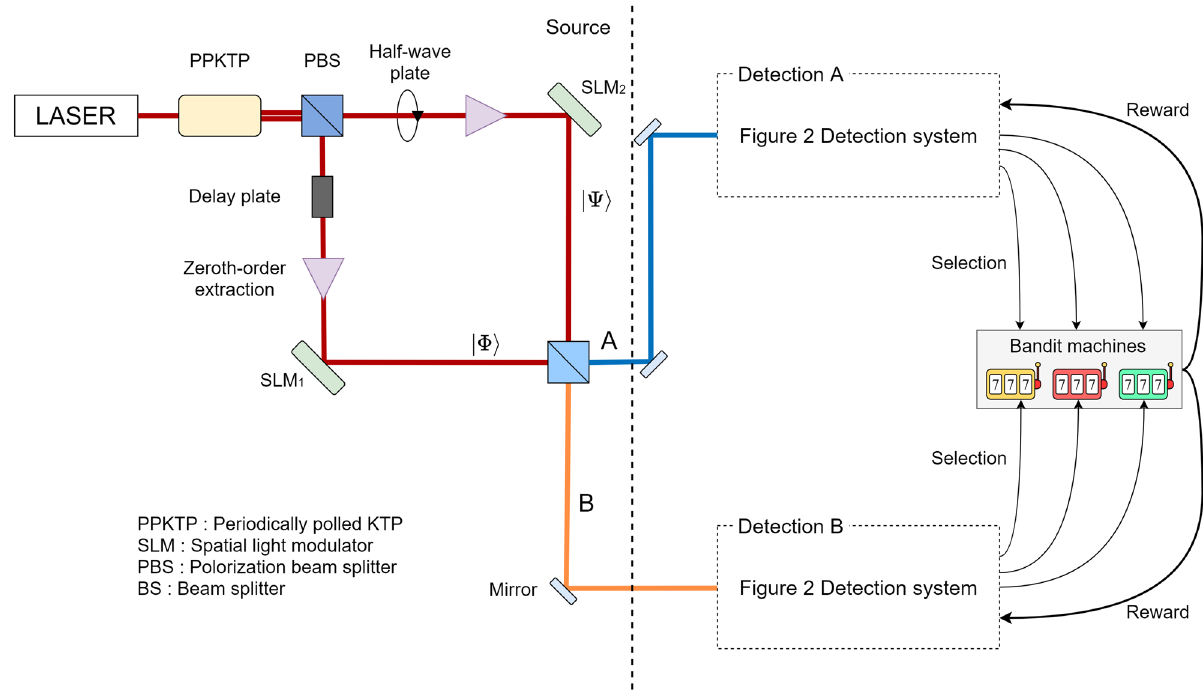
Figure 4. System architecture for solving 2-player 3-armed bandit problem.